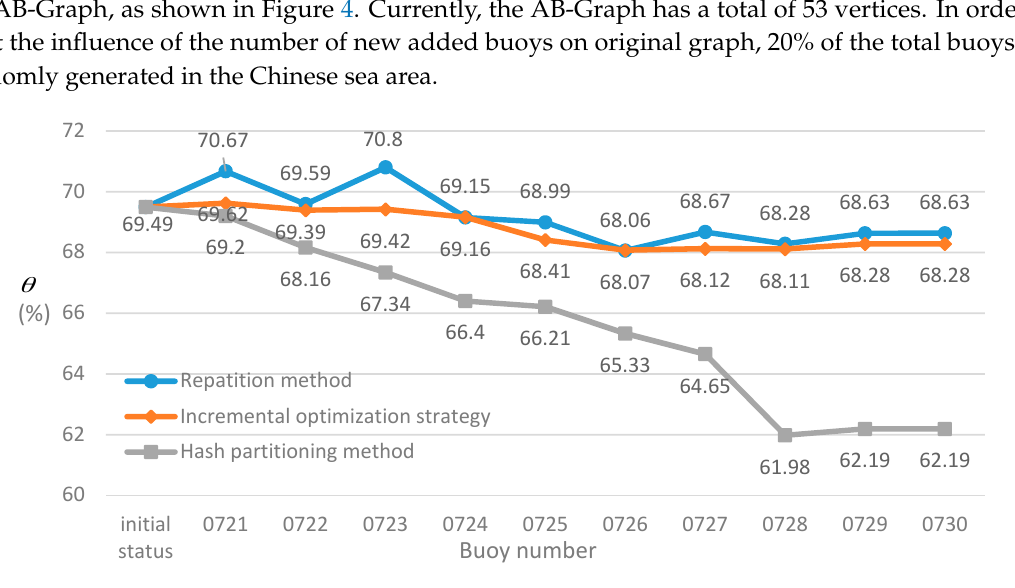
Figure 4. The change of the three methods on the θ when the buoy number increases.